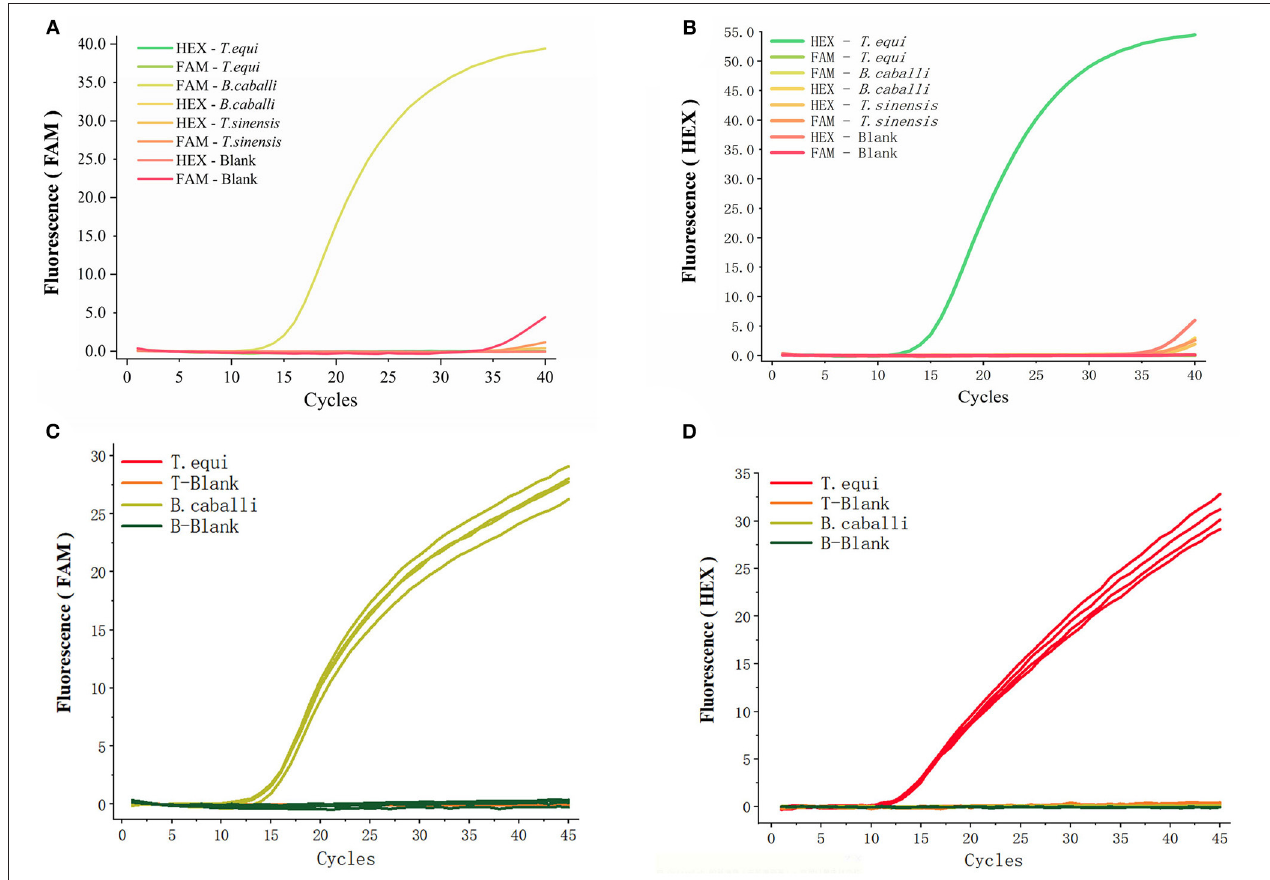
FIGURE 3 | Specificity of the primers and probes for duplex real-time fluorescence quantitative PCR. (A,B) obtained from FAM panel and HEX panel, respectively. Various probes and templates were added to the reaction system. T. sinensis is unrelated DNA and used as a control. (C,D) Two different types of primers and probes were added into one reaction and there were four repeated samples, only the template was